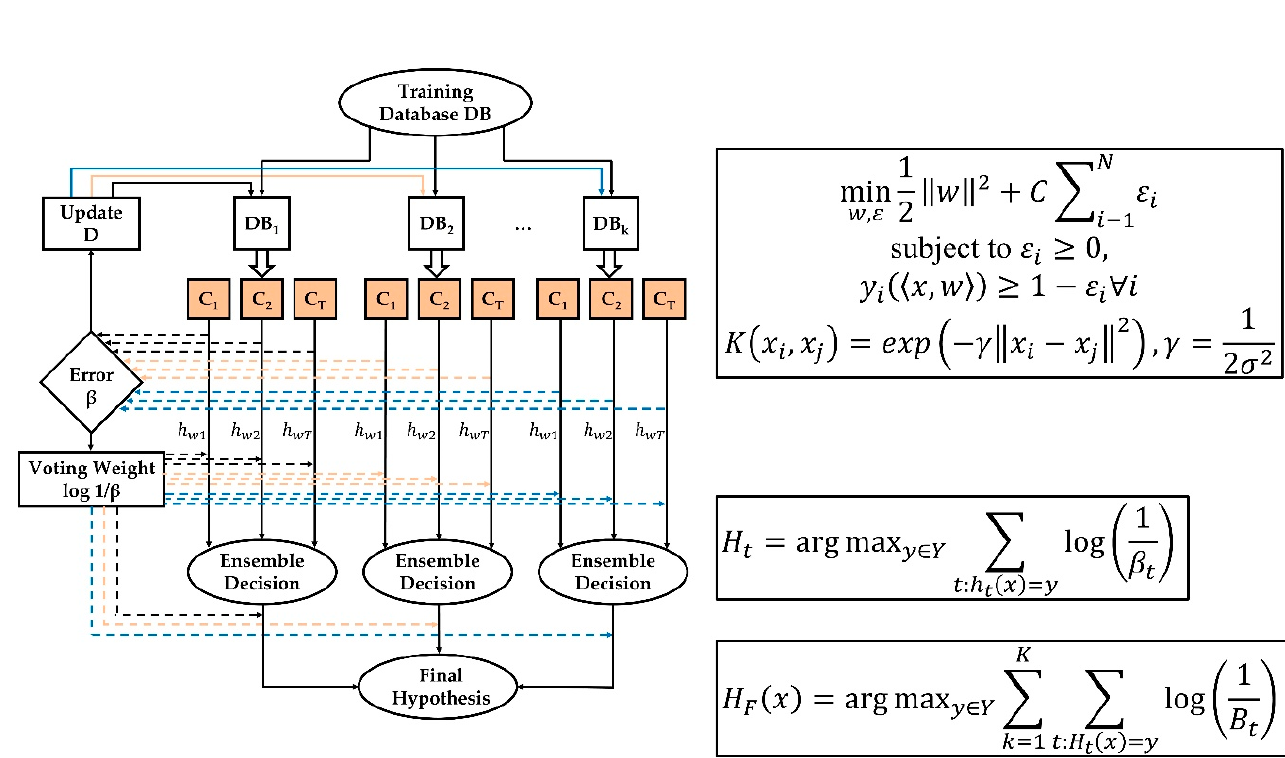
Figure 2. Schematic representation of the incremental learning ensemble classifier (altered from [20])